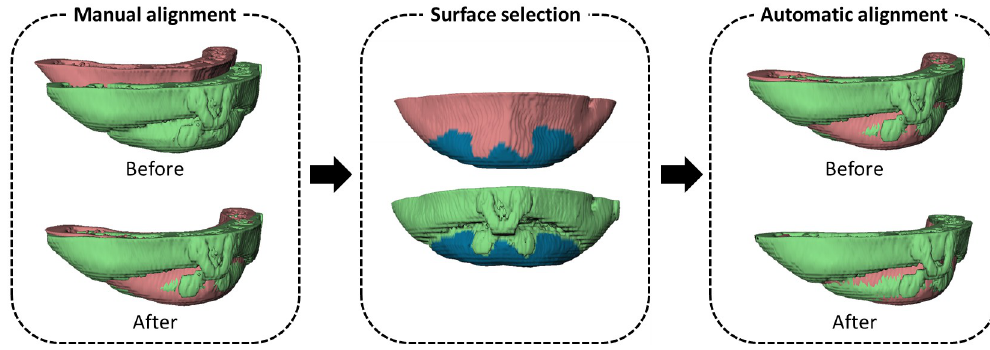
Fig 2. Surface-based matching of the chin. The preoperative chin model (red) was first manually aligned to the postoperative chin model (green). The user needed to select the surface on both models (blue). The selected surface will be used for the automatic surface-based